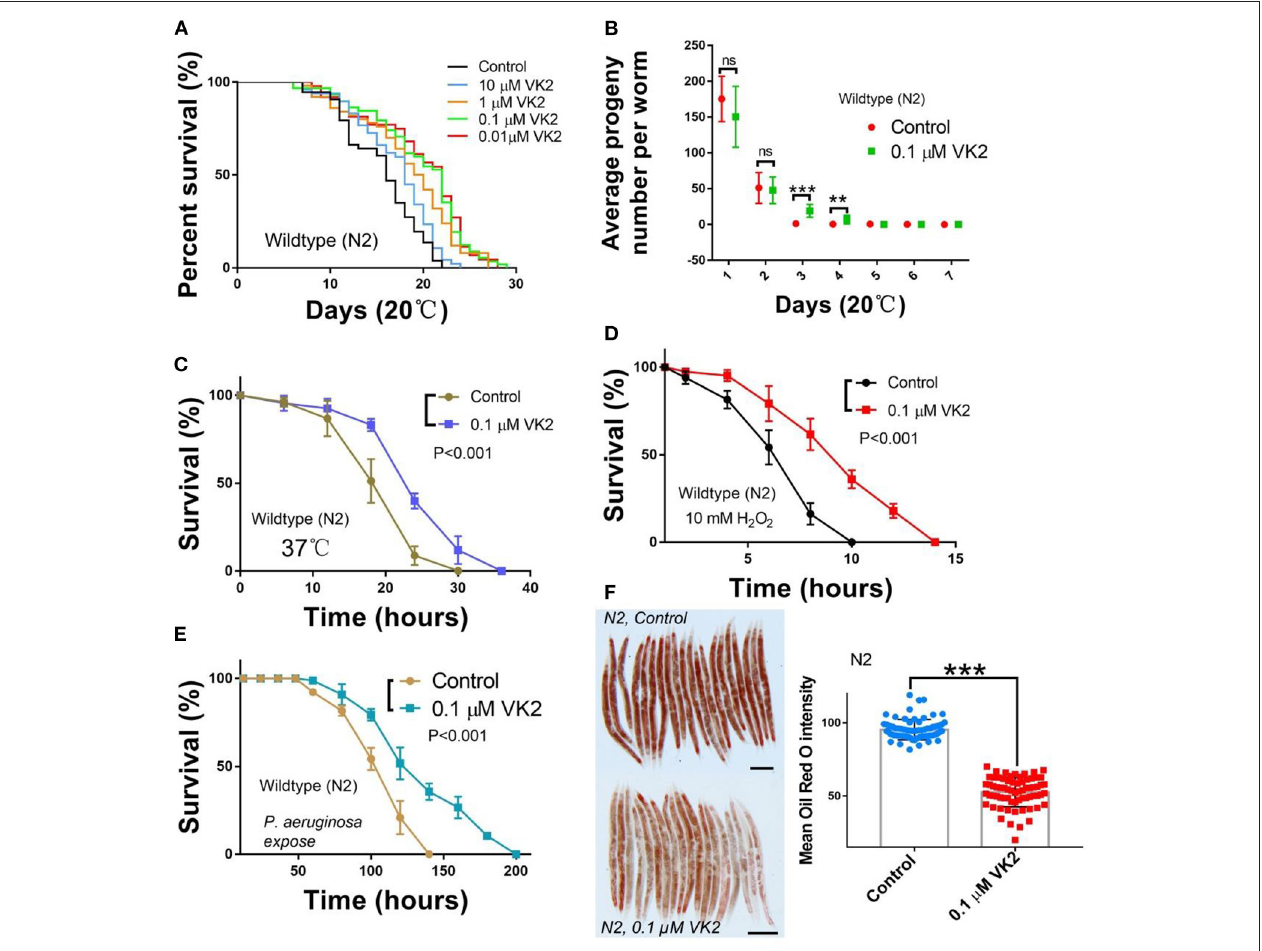
FIGURE 1 | VK2 extends the lifespan of N2 worms and improves survival under stress. (A) Wild-type N2 worms were treated with different concentrations of VK2; 0.1 µ M VK2-treated worms had the strongest longevity extension. The treatments were repeated at least three times, and the sample size was larger than 60 worms in each treatment. The data are summarized in Table 1 . (B) 0.1 µ M VK2-treated N2 worms had longer productive spans and more progeny at day 3 and day 4. The treatments were repeated at least three times, and the sample size was larger than 20 in each experiment. The survival of N2 worms was improved under heat (C) , H 2 O 2 (D) , and P. aeruginosa treatments (E) . The treatments were repeated at least three times, and the sample size was larger than 60 worms in each experiment. The P -values were carried out using a t -test. (F) VK2-treated N2 worms had a lower fat content compared with the controls. Oil Red O was used to stain the fat droplets in the worm body, and the changes in lipid content were analyzed using Image J software. The treatments were repeated at least three times, and the sample size was larger than 30 in each experiment. Scale bar: 100 µ M. *** P < 0.001. VK2, vitamin K2. ** P <